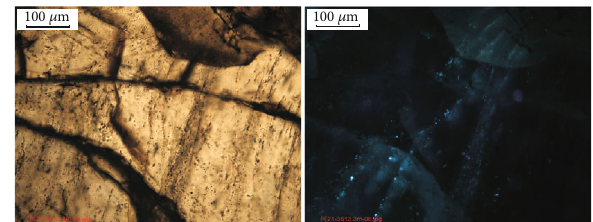
(a) Blue fl uorescent inclusions distributed along the micro fractures cutting through some quartz particles, 3613.3m, 50 𝜇 m